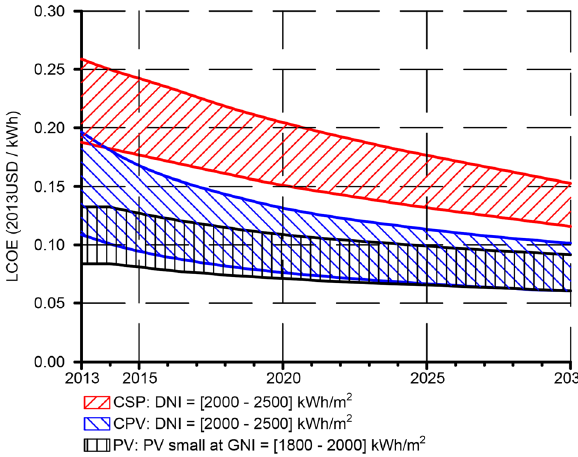
Figure 26: LCOE trend for electricity generation of solar concen - trating in places with high solar radiation. ( Retrieved from: Philipps S, Bett A, Horowitz K, Kurtz S. Current status of concentrator photovoltaic ( CPV ) technology. Golden ( CO, USA ) : NREL; 2016. Report No. NREL/TP - 6A20 - 63916 [ 161 ] . )